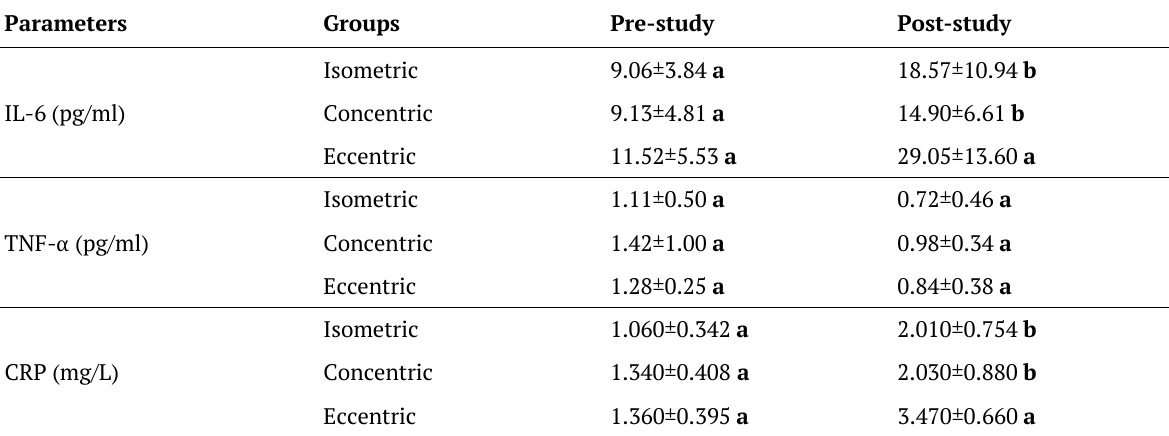
and IL-6 stokin levels between groups before and after the study α